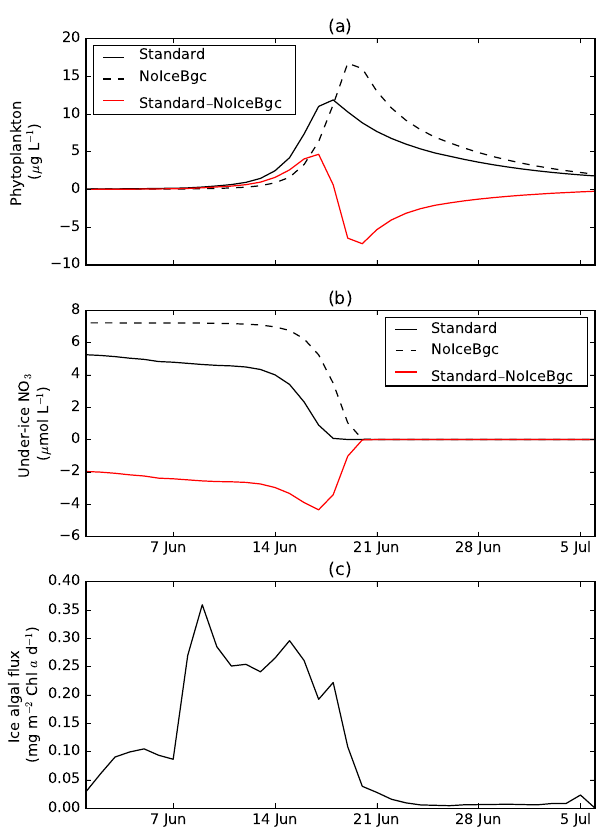
Figure 6. Simulated time series of (a) phytoplankton biomass (µgChl a L − 1 ) and (b) nitrate concentration (µmolL − 1 ) in the up- permost layer (0.5m below the ice) of the water column during the melt period in 2010 for the standard run (Standard) and the sensi- tivity run that excluded both the sea-ice sulfur cycle and ecosys- tem (NoIceBgc). (c) Ice algal flux (mgChl a m − 2 d − 1 ) entering the large phytoplankton pool in the uppermost layer of the water col- umn. In panels (a) and (b) , red lines represent the respective differ- ences in phytoplankton biomass and nitrate concentration between the standard and sensitivity